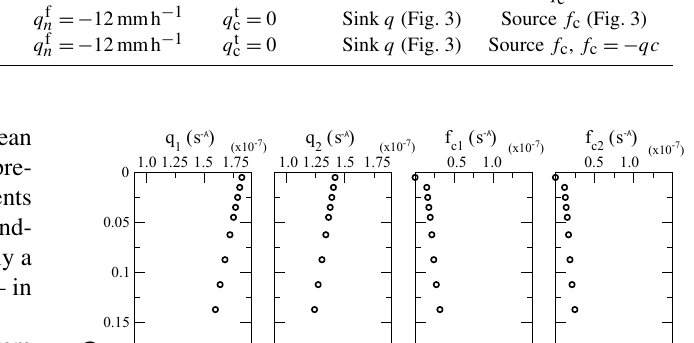
Table 1. Treatment of boundary conditions at the land surface during the rainfall and evaporation periods for the flow and transport models. Simulation Rain with Rain with no Evaporation (see Tables 2 and 3) 2 H -enriched water 2 H -enriched water (between rain pulses and (second pulse) (first and third pulses) after the third pulse) Flow Transport Flow Transport Flow Transport